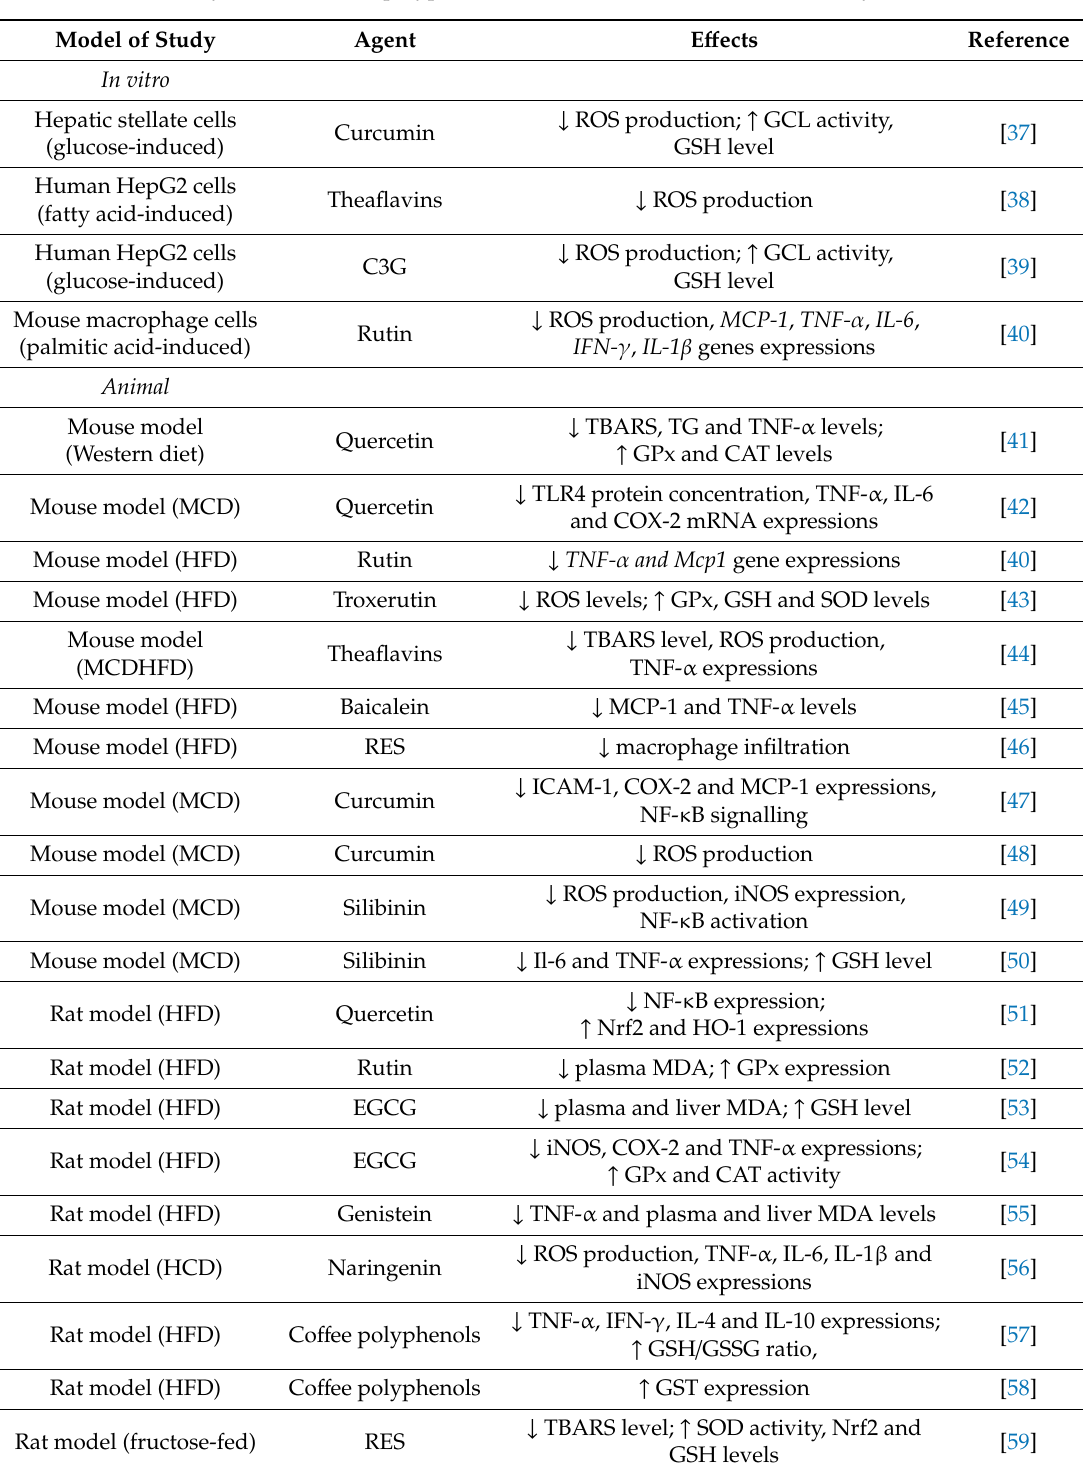
Table 2. Summary of the e ff ects of polyphenols on liver inflammation in the last 15 years